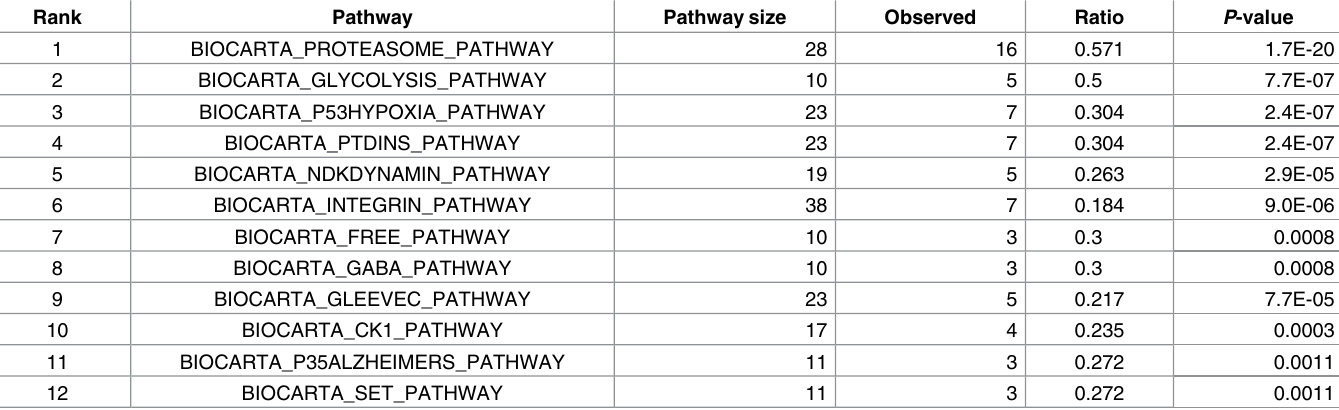
Table 3. Top-ranked pathways by BioCarta analysis.